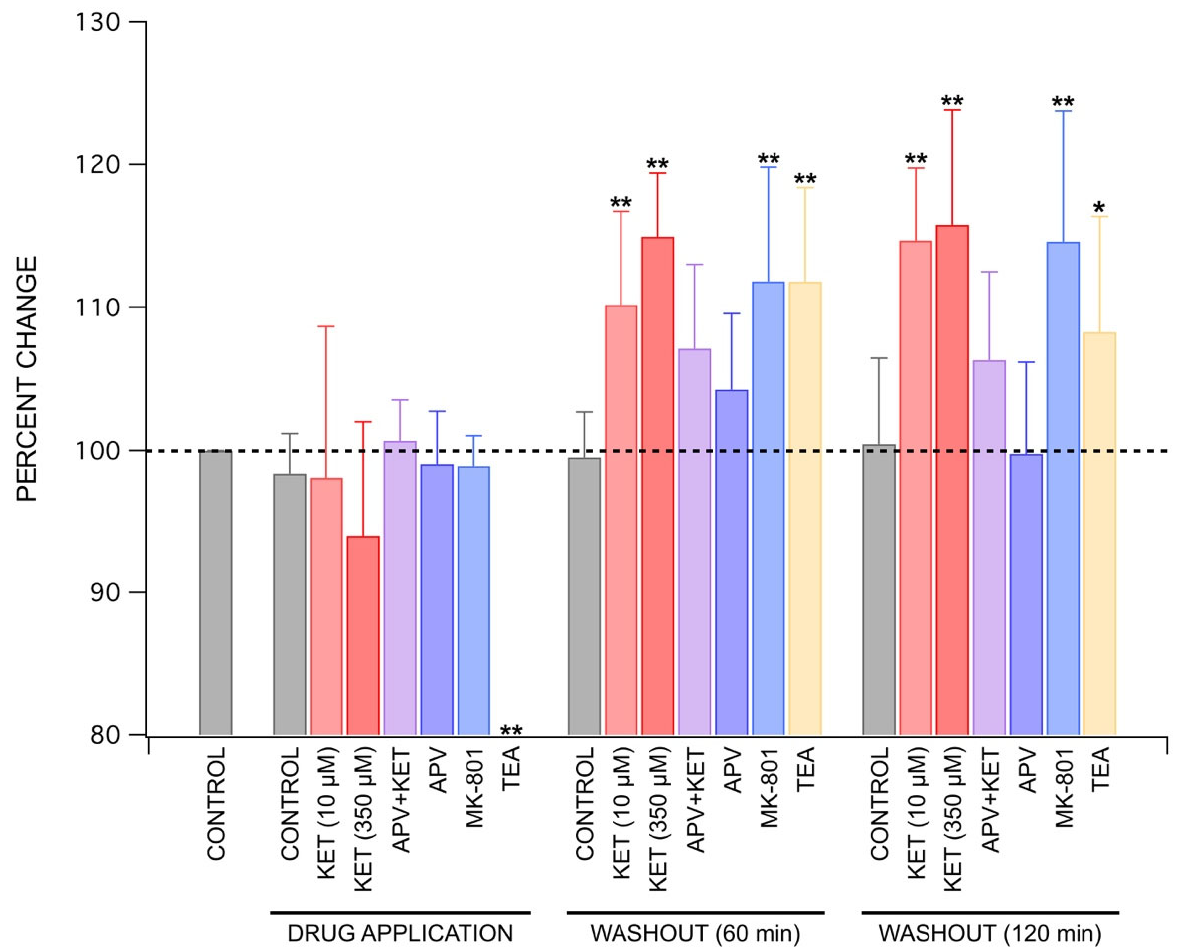
Figure 5. Summary of drug effects on population spike amplitudes. Ketamine decreased PS amplitudes during application at both anesthetic and antidepressant concentrations, with 350 µ M exhibiting a larger decrease compared to 10 µ M. Both concentrations of ketamine significantly increased PS amplitudes at 60 min and 120 min into washout, with 350 µ M inducing the larger increase of the two. MK-801 was able to best replicate the effects produced by ketamine, as evidenced by a decrease in PS amplitude during application, followed by a statistically significant increase in amplitudes during washout at both 60 and 120 min. Similarly, washout of TEA was able to produce a statistically significant increase in PS amplitudes at both 60 min and 120 min. However, the decrease in PS amplitudes produced during application of TEA was much larger than that produced by ketamine, and statistically significant. Each bar represents the mean ± standard deviation for at least four experiments using separate brain slices prepared from different animals. Statistically significant differences are indicated using ** ( p < 0.01), * ( p < 0.05). Significance was assessed using Wilcoxon Rank Test to compare each experimental condition to its respective